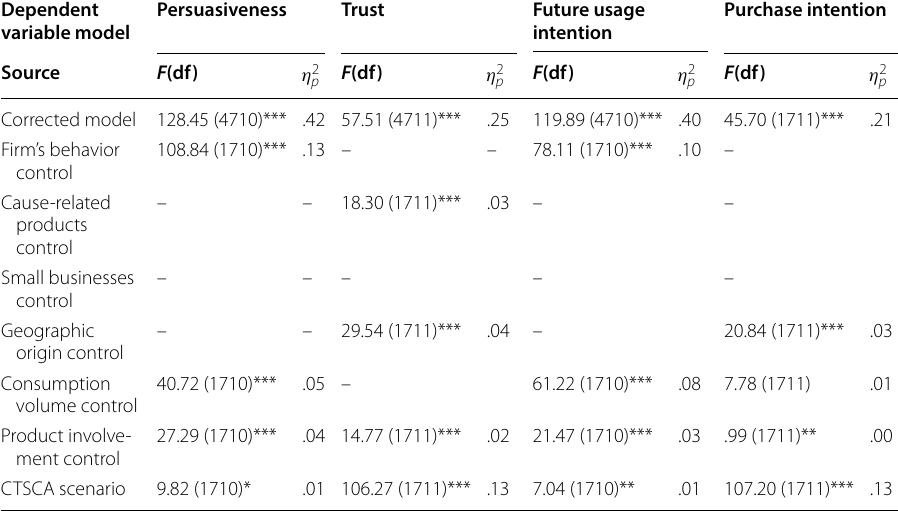
Table 4 Results of analysis of